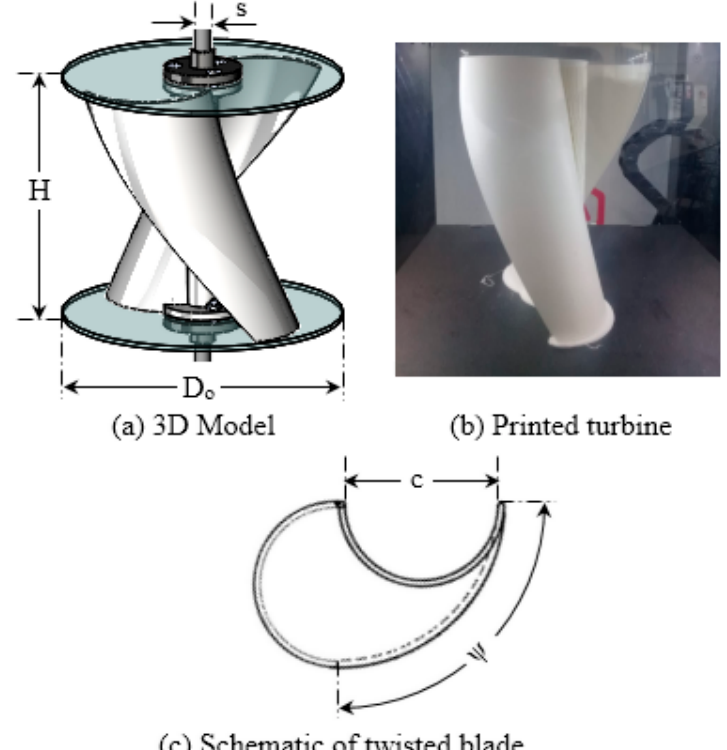
Figure 3. Savonius Rotor. Figure 3. Savonius